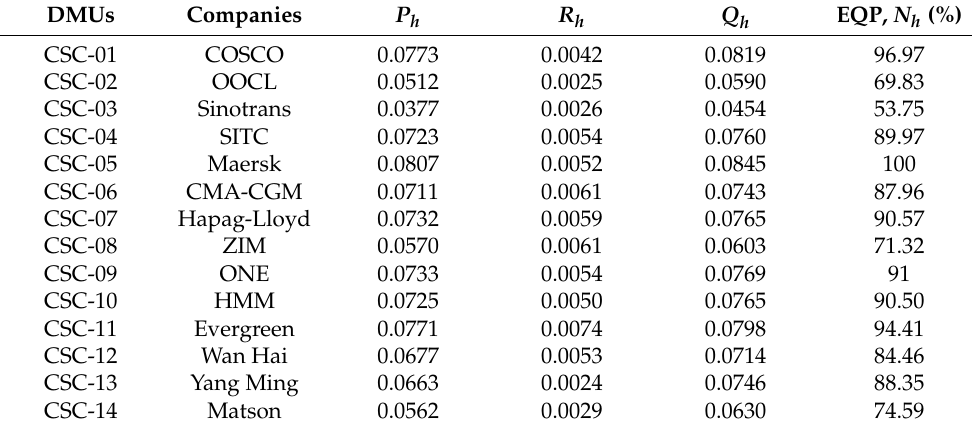
Table 13. The evaluation of the utility degree of the COPRAS-G